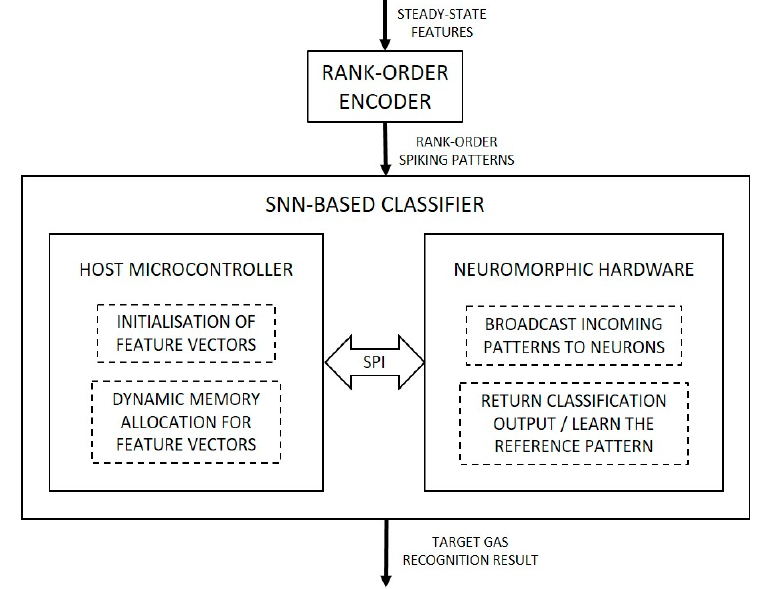
Figure 1. Block diagram of the classification system with its important components and sub- processes.